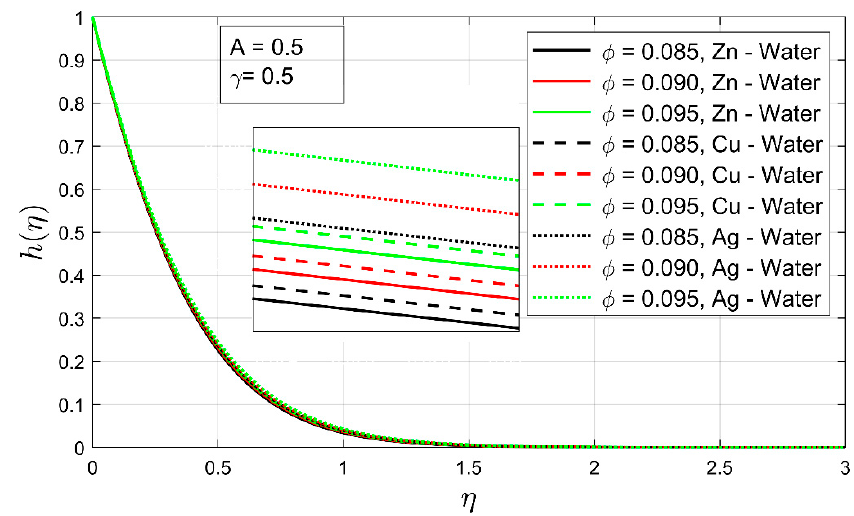
Figure 8. The temperature profile h ( η ) as a function of volume concentration φ .